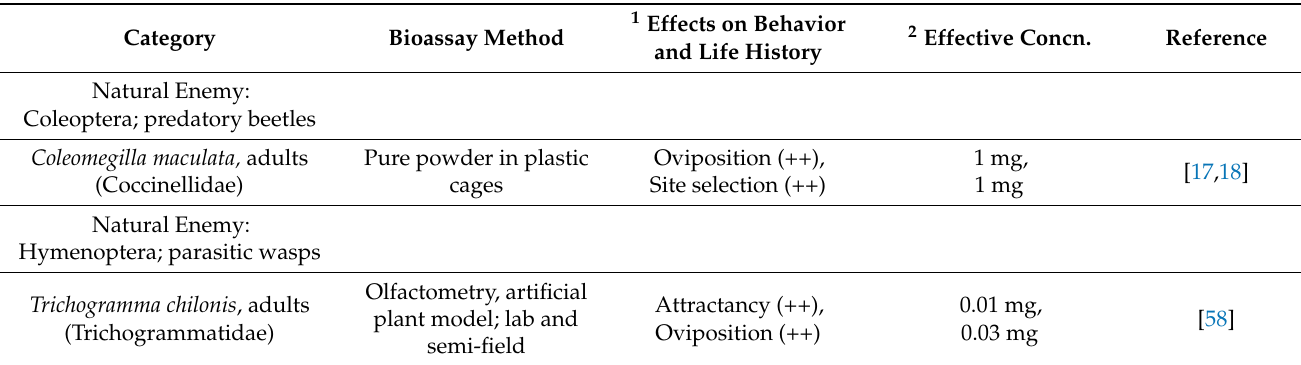
Table 2. Research that tested the effects of quercetin on natural enemies.